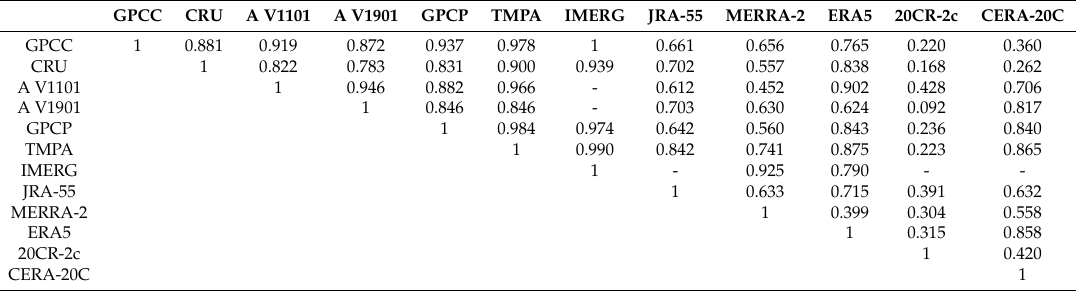
Table 4. Correlation matrix of the Indus basin mean annual precipitation time series between data sets. The correlation for each pair is based on their period of overlap (Table 1). A = APHRODITE.